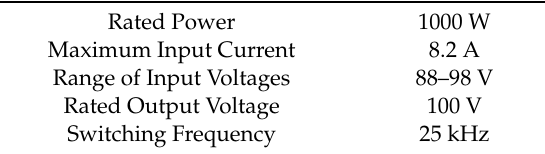
Table 3. Main features of the converter.